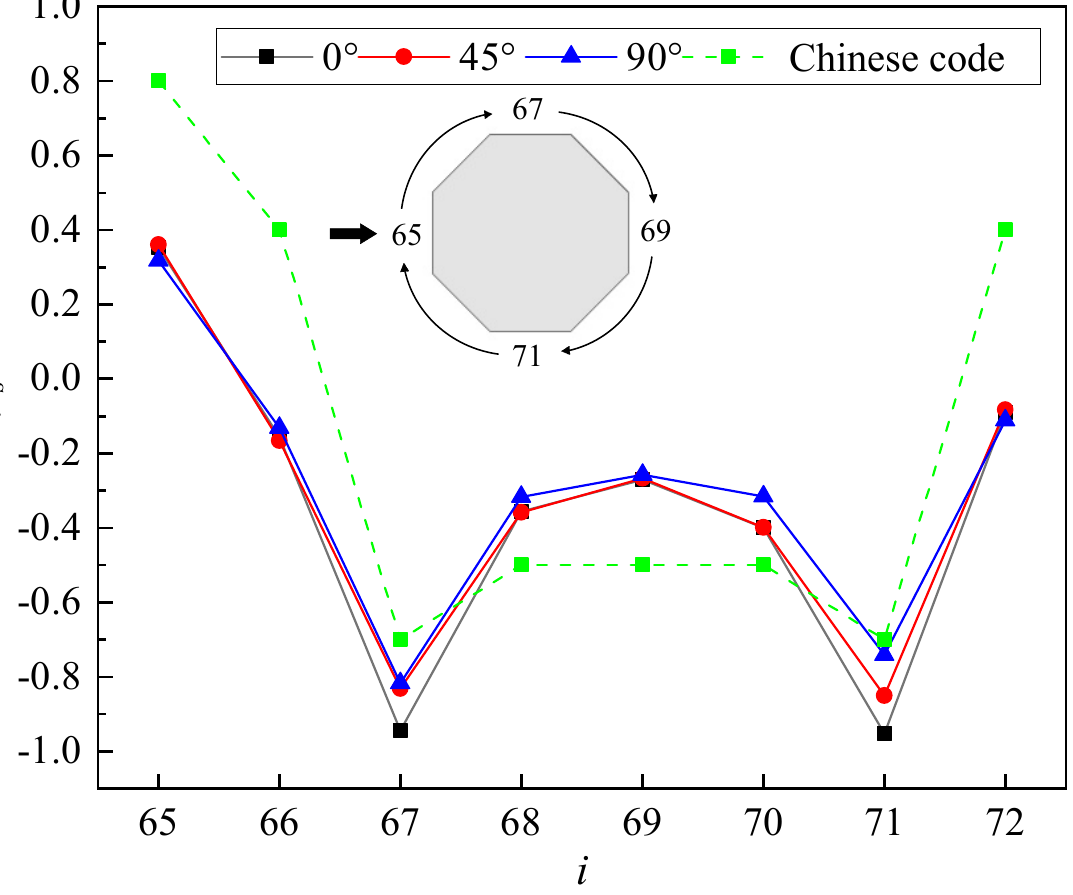
Figure 36. Mean shape coefficients of the different wind-affected zones at 0°, 45°, and 90° wind direction angles. Table 5. Mean shape coefficients of different wind-affected zones at 0 ◦ , 45 ◦ , and 90 ◦ wind direction